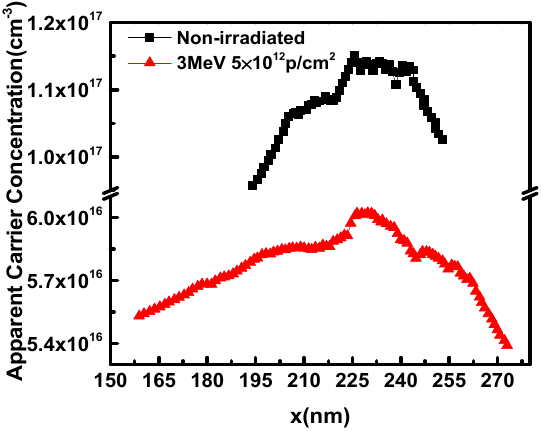
Figure 3. The apparent carrier concentration profile.